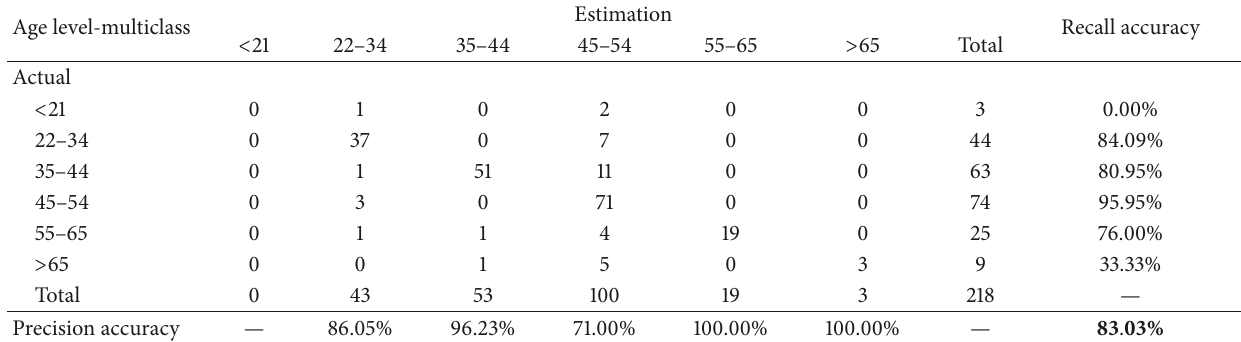
Table 5: Age level multiclass SVM prediction results.